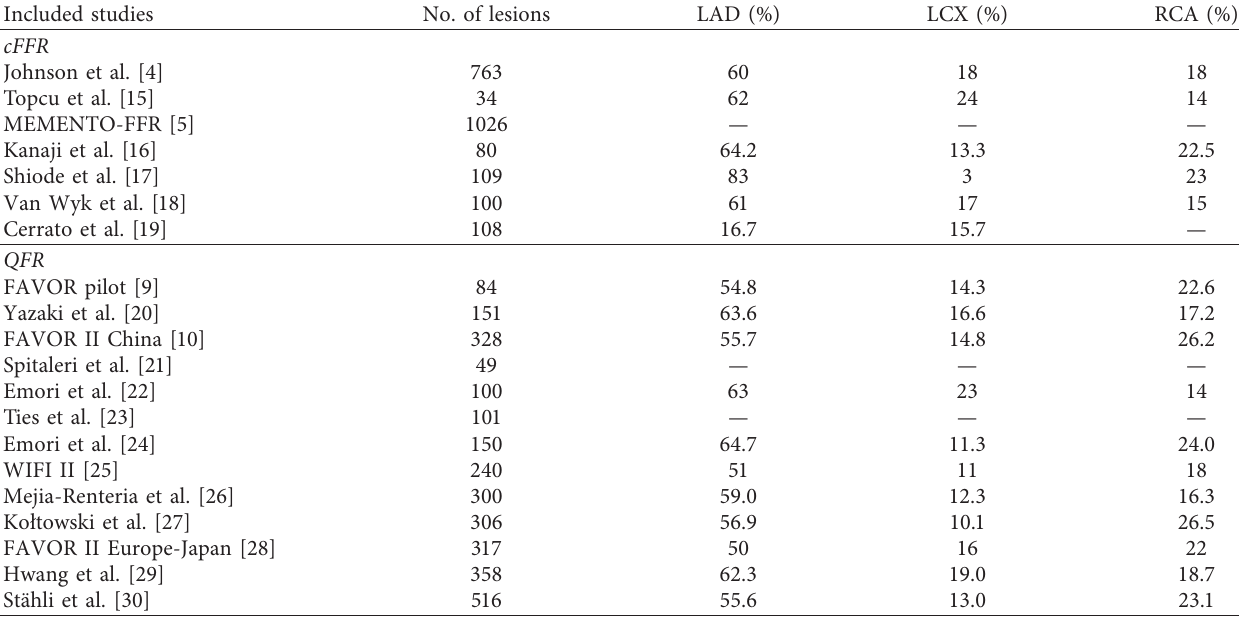
Table 3: Baseline angiographic